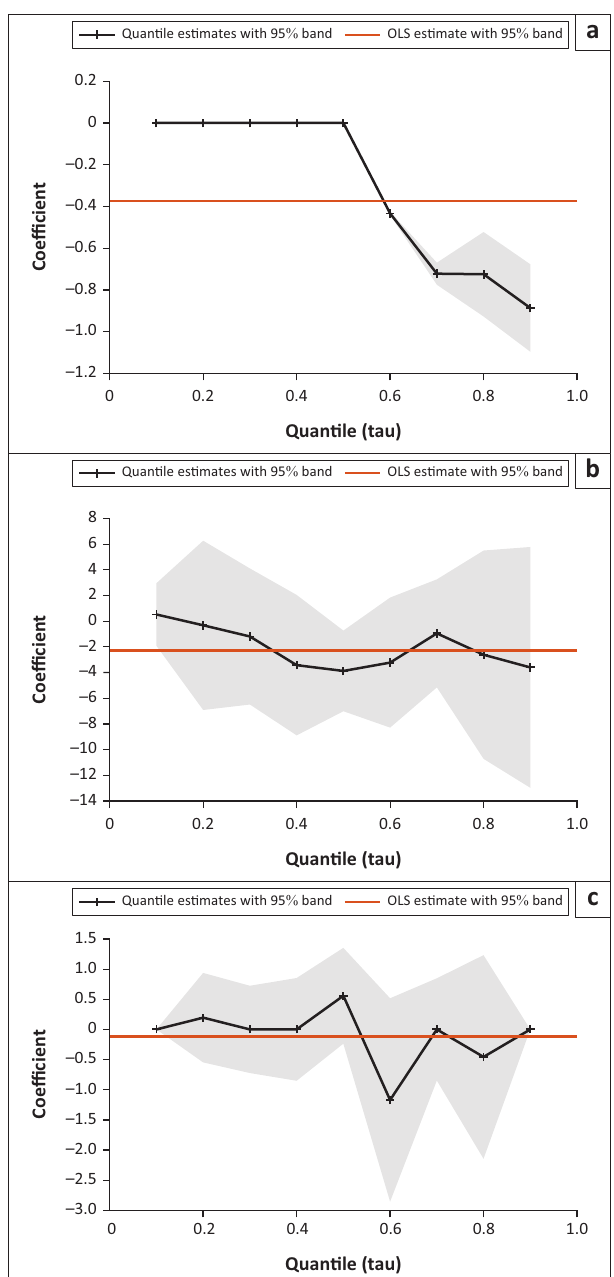
FIG URE 4: Relationship between own revenue and gross domestic product growth rate. FIG URE 5: Quantile